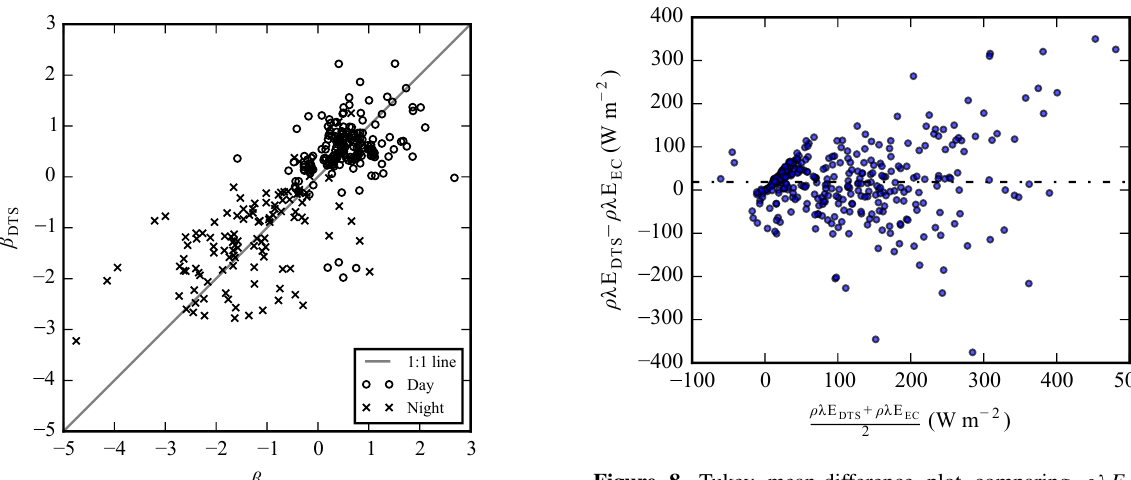
Figure 8. Tukey mean-difference plot comparing ρλE EC and ρλE DTS . With µ = 18 . 7Wm − 2 , RMSE = 90Wm − 2 (15min av- erages). Data from 10, 12–14, 19–22, and 28–30 August 2016.